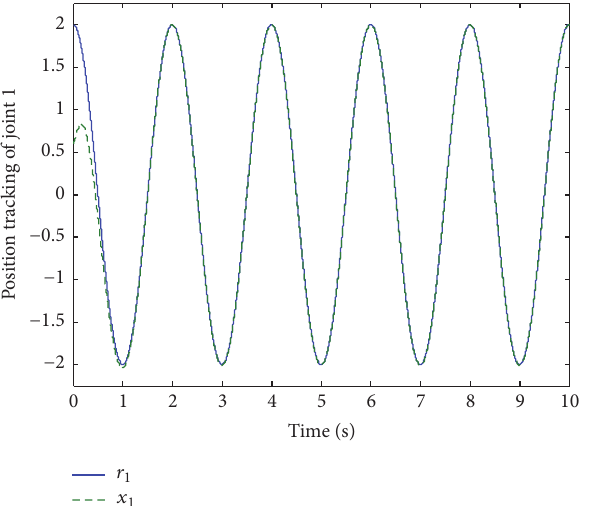
Figure 3: Actual value 𝑥 3 and tracking state of input signal 2.